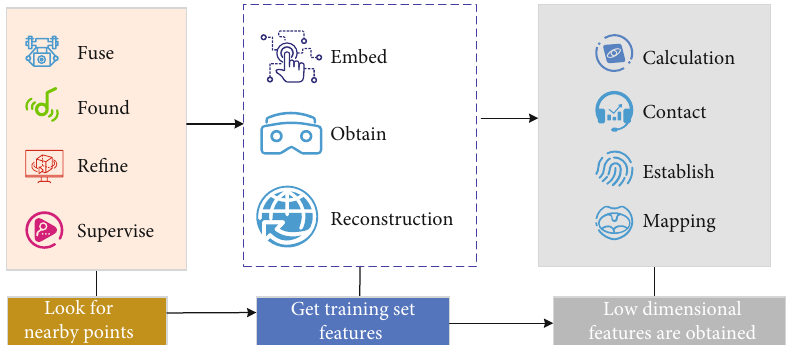
Figure 1: Implementation process of the nonlinear dimensionality reduction algorithm.